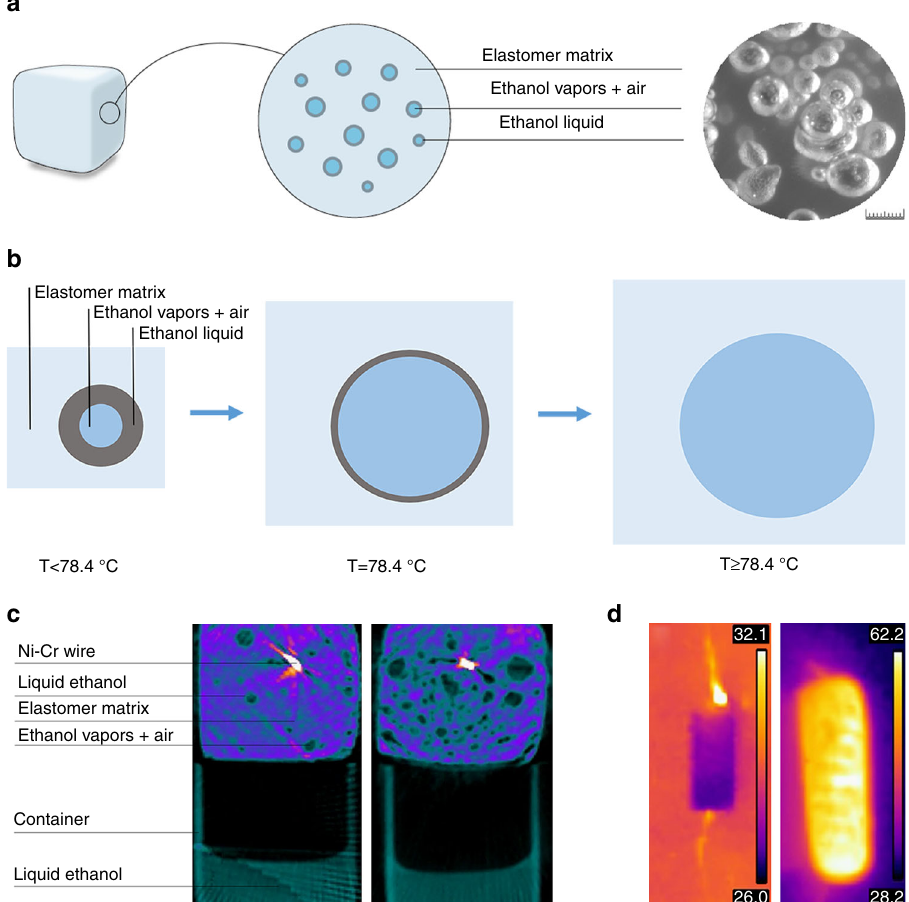
Fig. 2 Structure and principle of operation of the soft composite material. a Microstructure: Illustration and a stereoscope image; scale bar is 1 mm. b Illustration of the expansion process on example of a single ethanol bubble. c Micro-CT images of the material cross-section at room temperature and during heating. d Infra-red images of the material as the heating starts and during expansion; the material is heated using Ni – Cr resistive